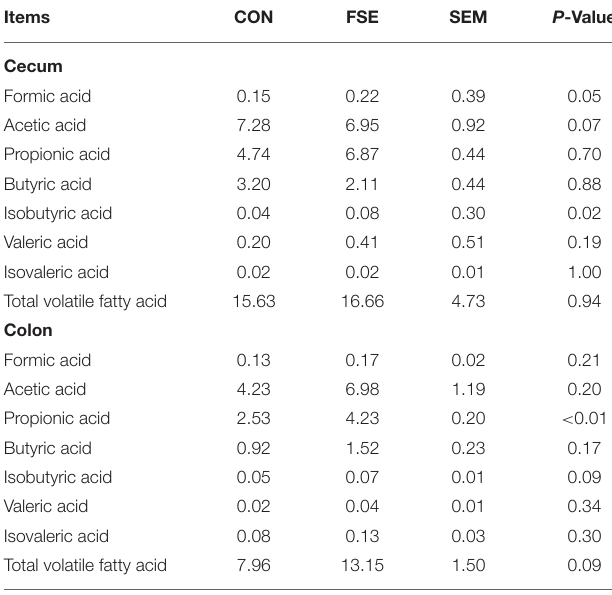
TABLE 4 | Effects of maternal dietary Forsythia suspensa extract supplementation on the contents of total volatile fatty acid in digesta of suckling piglets (mg/kg). Items